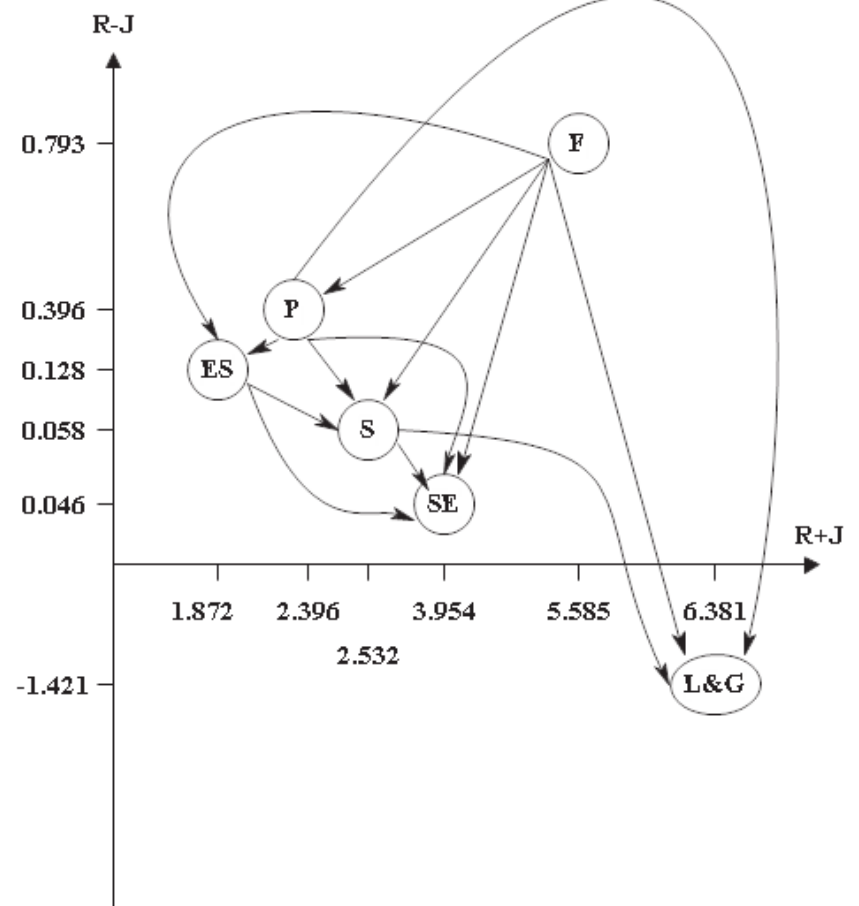
Fig. 5. Causal diagram of dimensions of knowledge management evaluation in Tehran Petrochemical Industries with